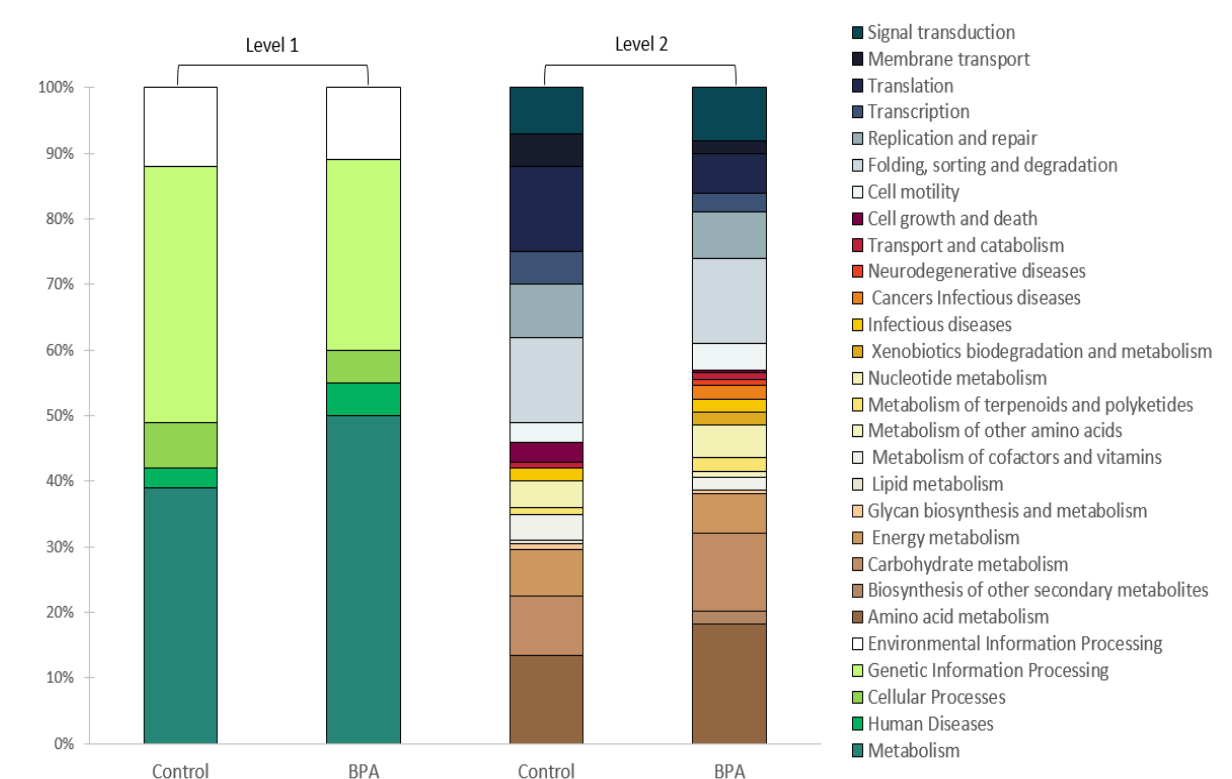
Figure 2. Gene expression classification of control and BPA samples based on KEGG Orthologs in MG-RAST. Samples were annotated at Level 1 in five categories (metabolism, human diseases, cellular processes, genetic information processing, and environmental information processing) and the sub-functions that correspond to the Level-1 categories are shown at Level 2 (default settings were assumed: alignment length: 15 bp, e-value: e-5, percent identity: 60%, minimum abundance: 3).